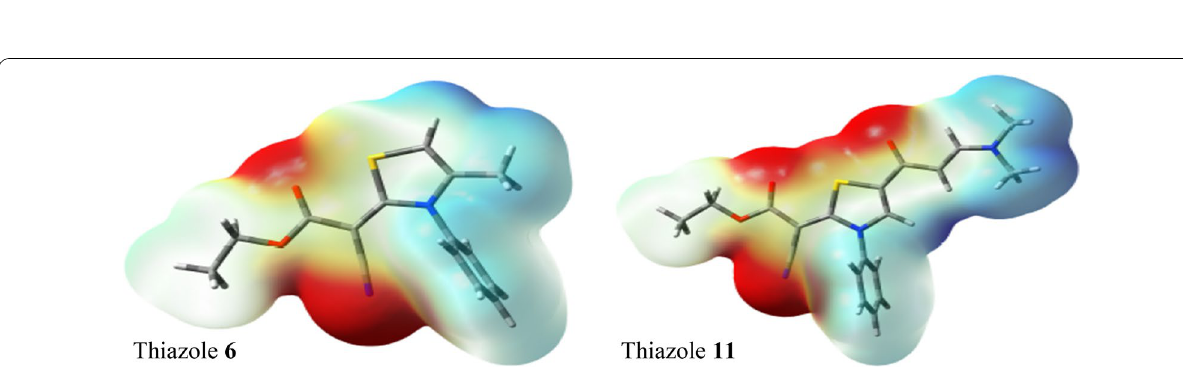
Fig. 7 The MEP figure of the thiazoles 6 and